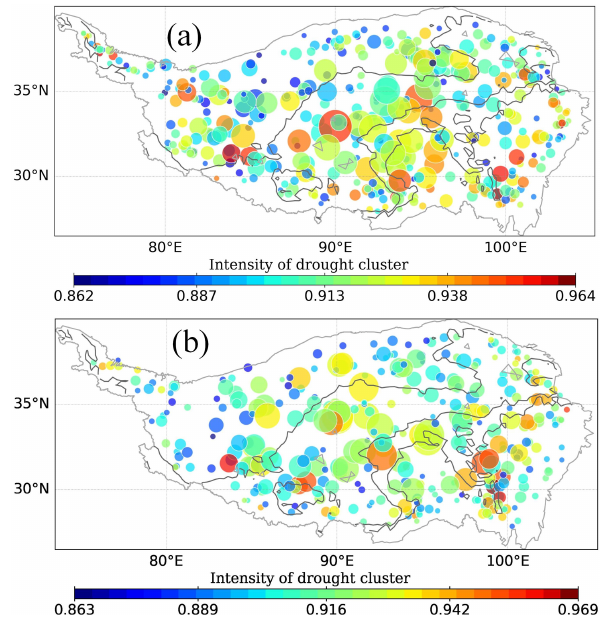
Figure 7. Map of the soil moisture drought clusters for (a) GLDAS and (b) ERA5. The circle center and size represent the centroid and area of the drought cluster, respectively. The light gray lines are the dividing lines between different climate zones (the same to Fig.